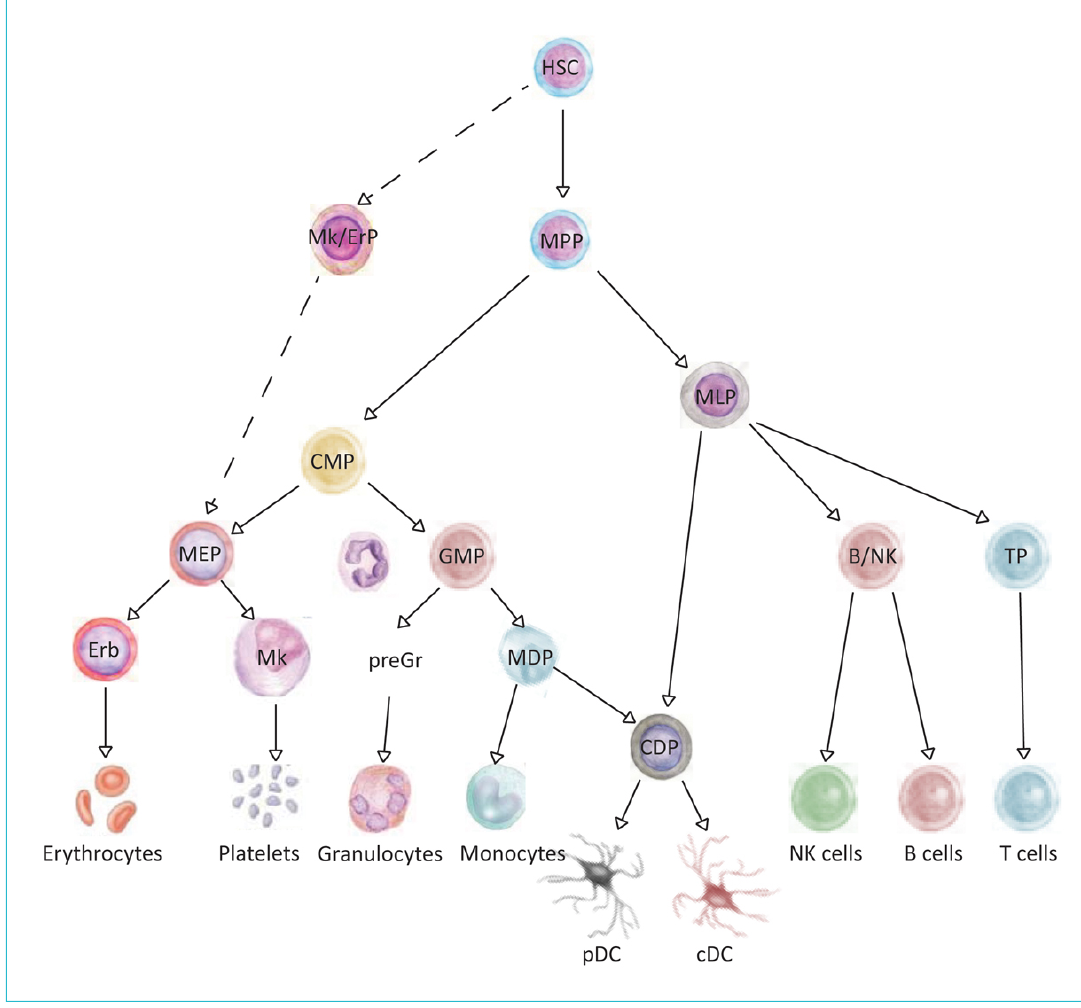
Figure 2: Hierarchy within human haematopoietic system. The tree-like organisation of the haematopoietic system is composed of haematopoietic stem cells (HSCs) with long-term self-renewal capacity that reside at the apex of the hierarchy and through multipotent and lin- eage-committed progenitors generate the differentiated mature cells with no or limited self-renewal capacity.B/NK = B and NK cell progenitor; cDC = conventional dendritic cells; CDP = common dendritic cell progenitor; CMP = common myeloid progenitor; Erb = erythroblast; GMP = granulocyte monocyte progenitor; HSC = haematopoietic stem cells; MDP = monocyte and dendritic cell progenitor; MEP = megakaryocyte- erythrocyte progenitor; Mk = megakaryocytes; Mk/ErP = megakaryocyte/erythrocyte progenitor; MLP = multi-lymphoid progenitor; MPP = mul- ti-potent progenitor; pDC = plasmocytoid dendritic cells; PreGr = pre granulocytes; TP = T cell